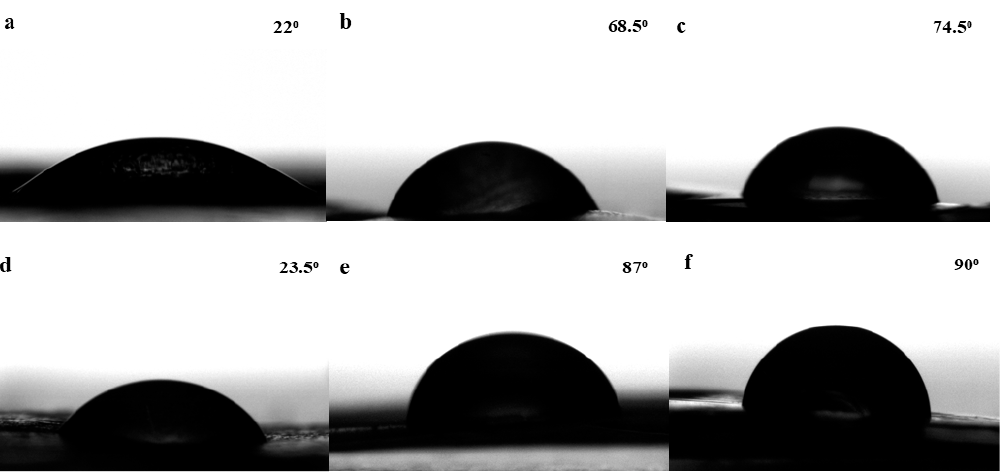
Figure 9. Contact angle measurement at T = 25 °C ( a – c ) and at T = 50 °C ( d – f ) of ( a , d ) MCC control, ( b , e ) cellulose(L)-PNIPAAm, and ( c , f ) cellulose(H)-PNIPAAm.